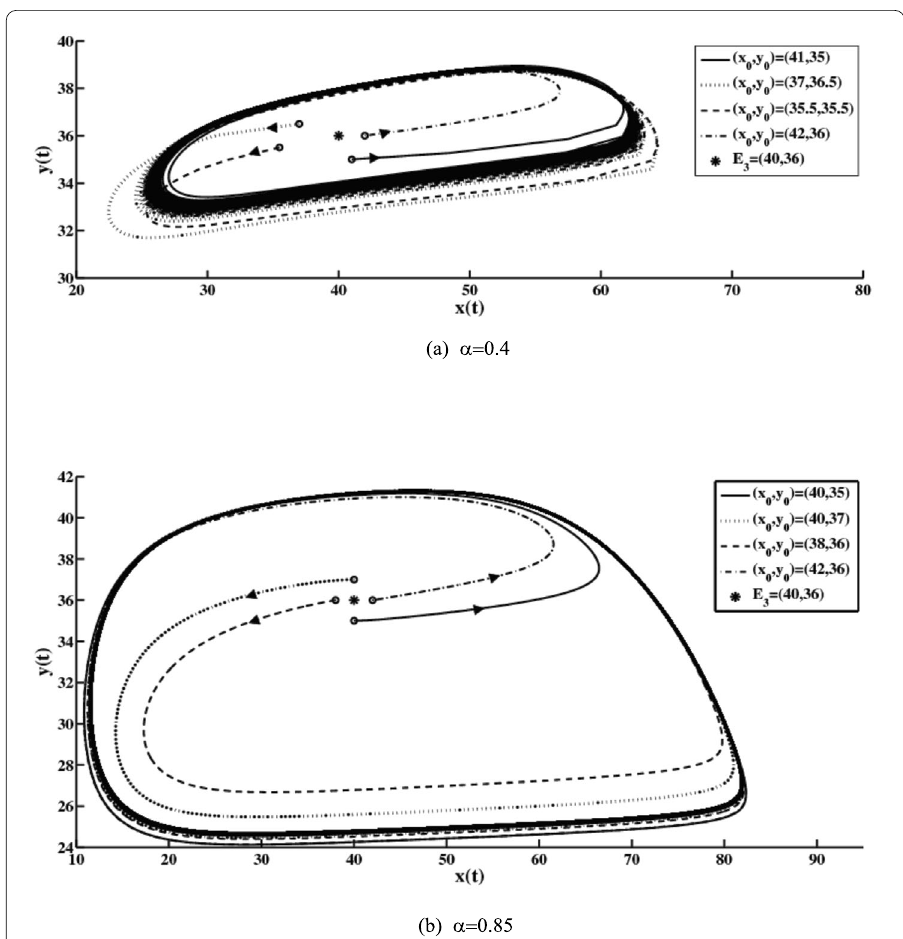
Figure 2 Dynamic behavior of model (3) with several initial conditions and the following parameters: s = 156, r = 3, K = 100, m = 1, a = 40, p = 4, and c = 2. ( a ) Derivative order α = 0.4 and ( b ) derivative order α =